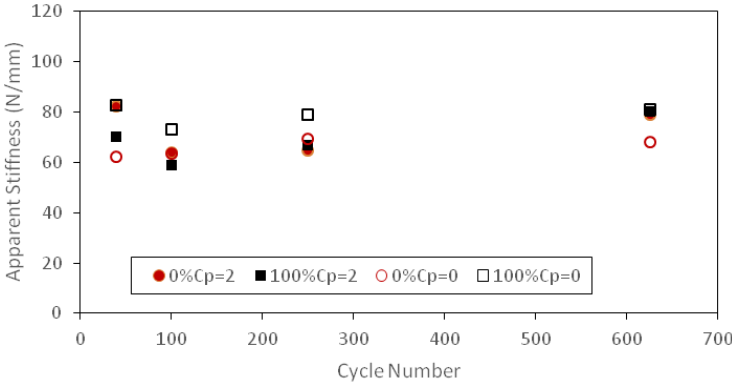
Figure 16. Apparent stiffness vs. number of cycles under 100 °C but different humidity levels and different cycle periods.